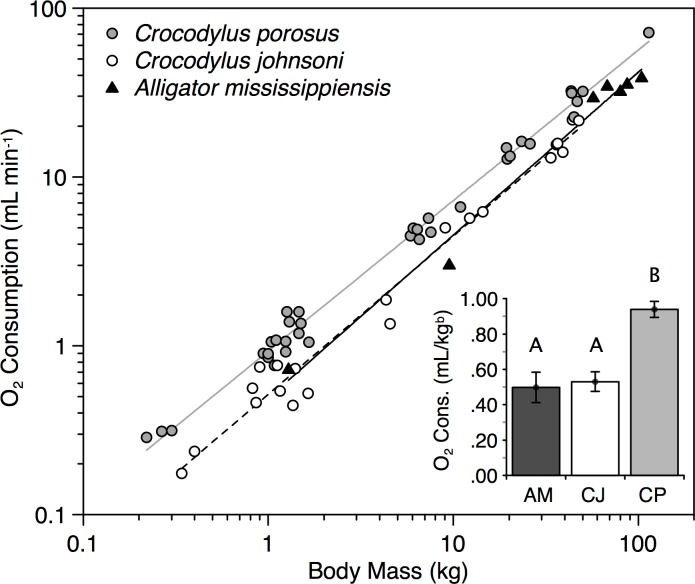
Scaling of standard metabolism (O2 consumption) for three species of crocodilians measured at 30°C.The highly aggressive Crocodylus porosus has significantly higher standard metabolism than the less aggressive Crocodylus johnsoni and Alligator mississippiensis. Inset figure shows mass-independent means (bars) and standard errors (error bars) of O2 consumption. Species not connected by same letter are significantly different.